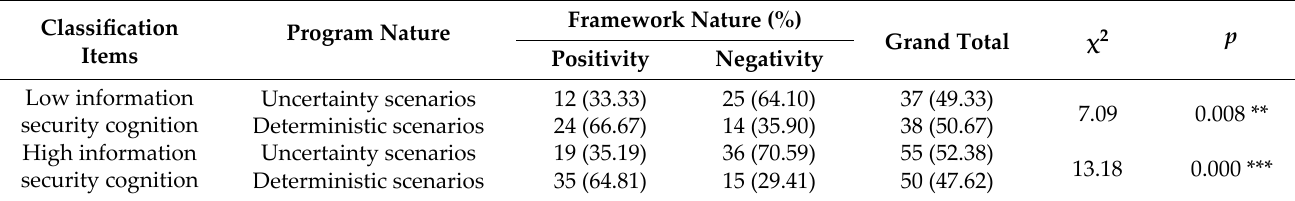
Table 18. Results of Cross‑Sectional (Chi‑Square)